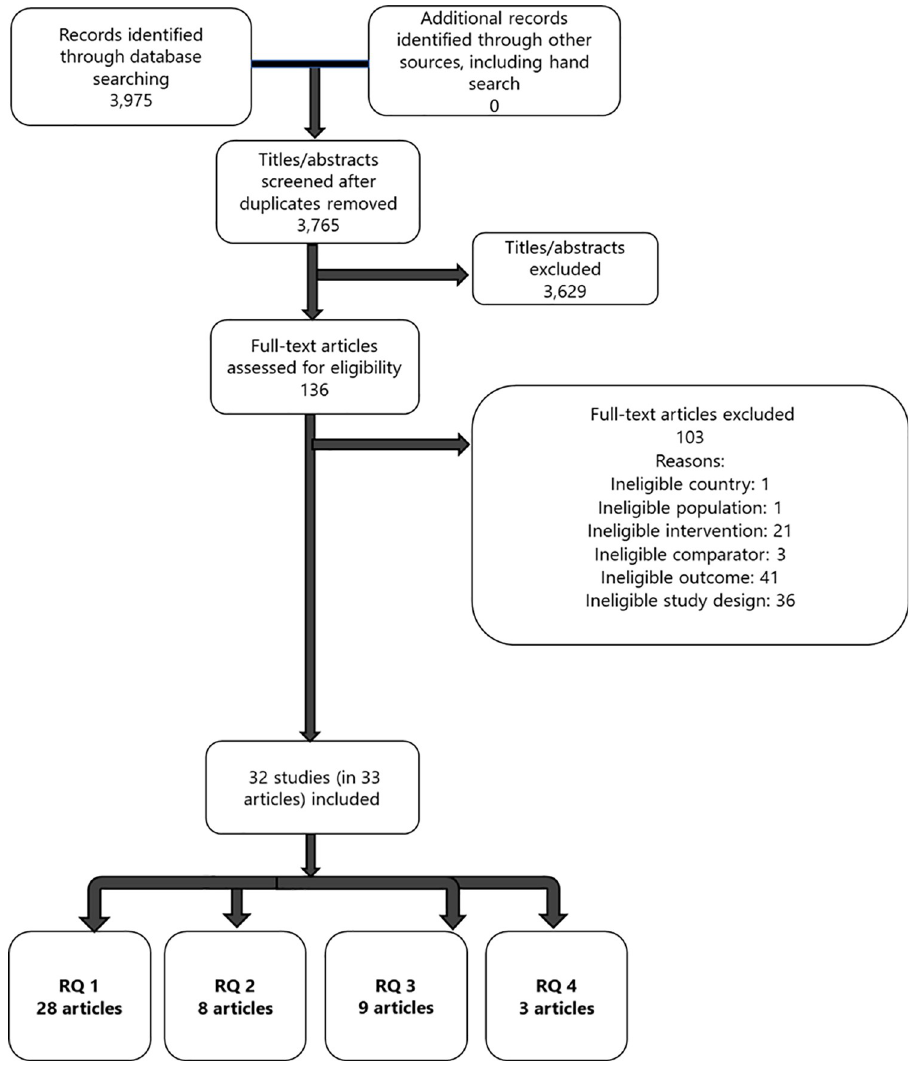
Fig 1. Preferred reporting items for systematic reviews and meta-analyses literature flow